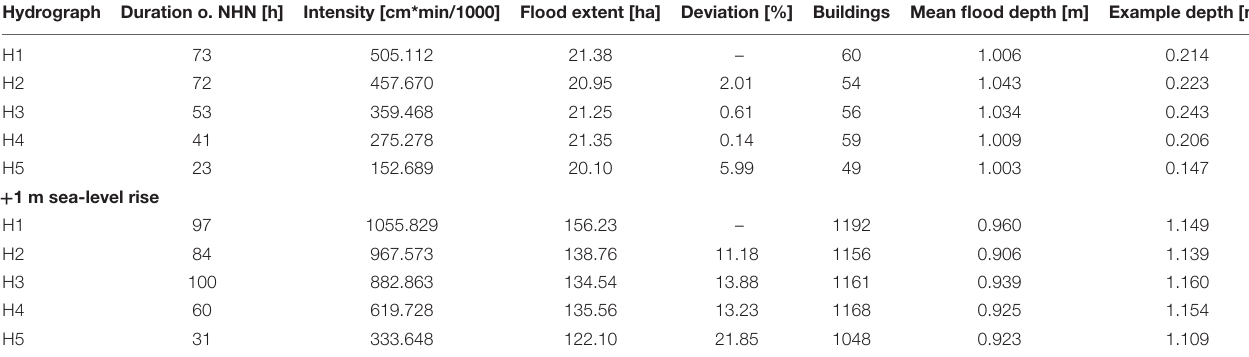
FIGURE 4 | Five selected hydrographs [H1 (A) , H2 (B) , H3 (C) , H4 (D) , and H5 (E) ] of the simulated storm surge events by MacPherson et al. (2019) for the tide gauge LT Kiel. TABLE 3 | Results for all five hydrographs with water levels corresponding to a 200-year return period and in combination with 1 m sea-level